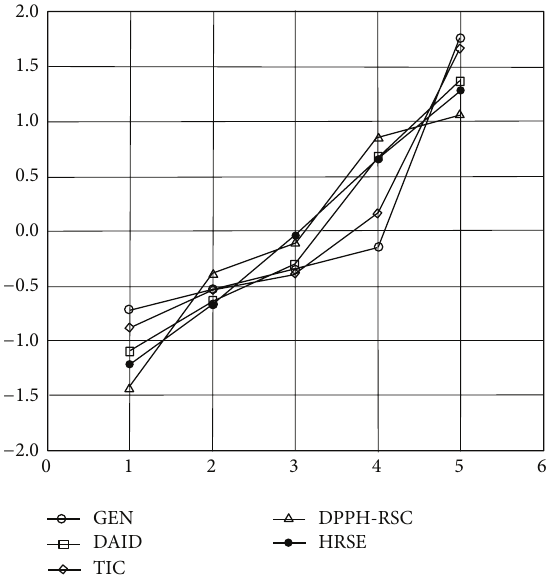
Figure 3: Autoscaling transformation of data for different antiox- idant markers with significant positive correlations (genistin and daidzin contents, TIC, DPPH RSC, and HRSE); GEN (genistin); DAID (daidzin); TIC (total isoflavone contents); DPPH-RSC (DPPH radical scavenging capacity); HRSE (hydroxyl radical scav- enging